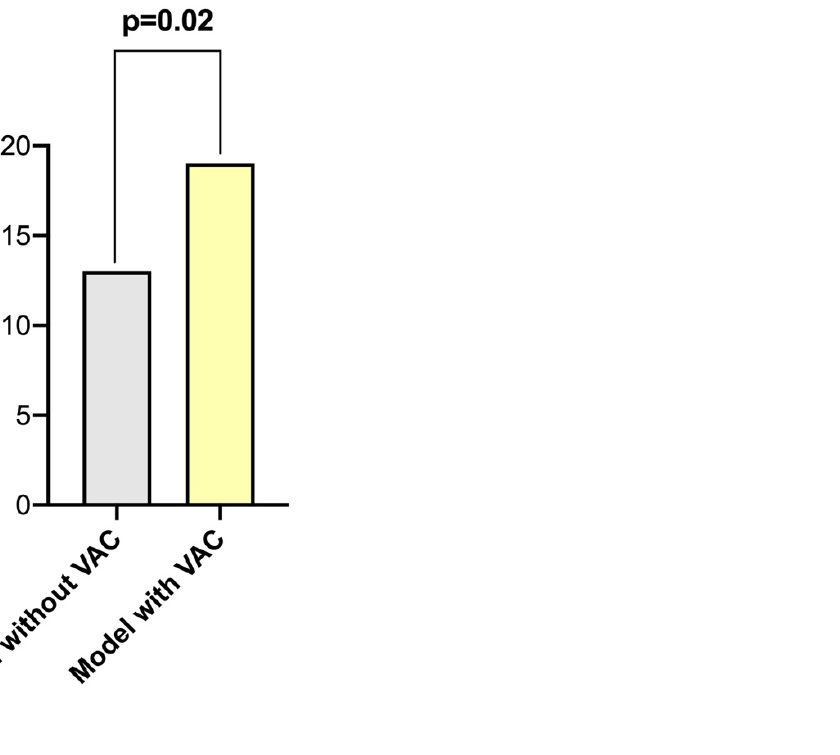
Figure 4. Incremental prognostic value of VAC > 0.63 when added to LVEF, LV efficiency, disease duration, age, sex, pulmonary hypertension, dcSSc and interstitial lung disease (Model 1).